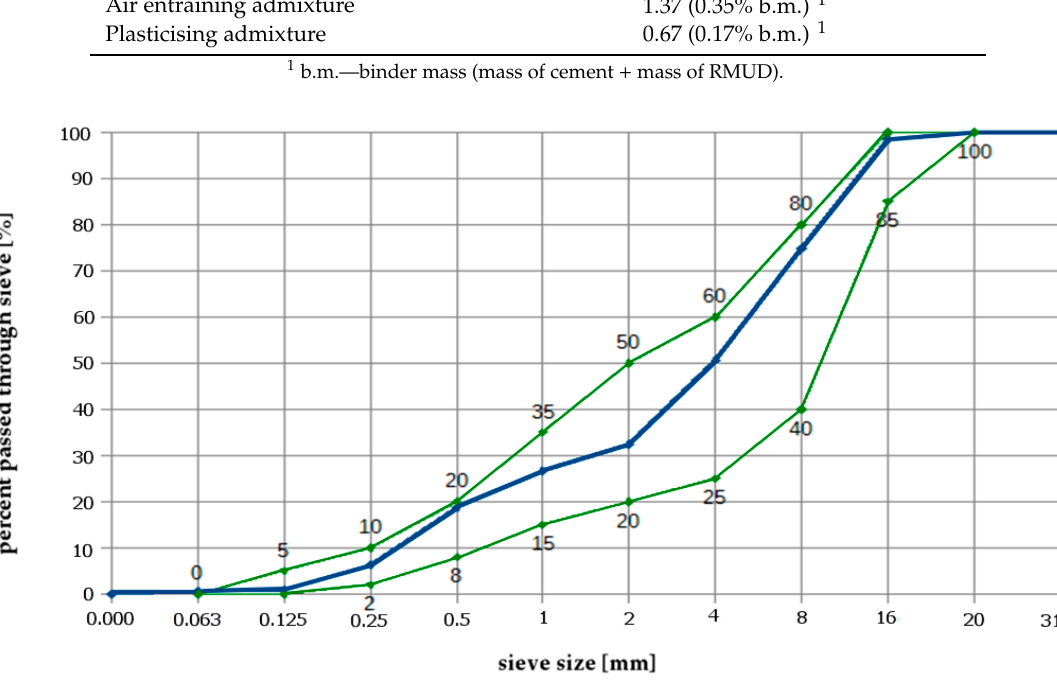
Figure 1. Sieving curves of aggregate mixes used for concretes.